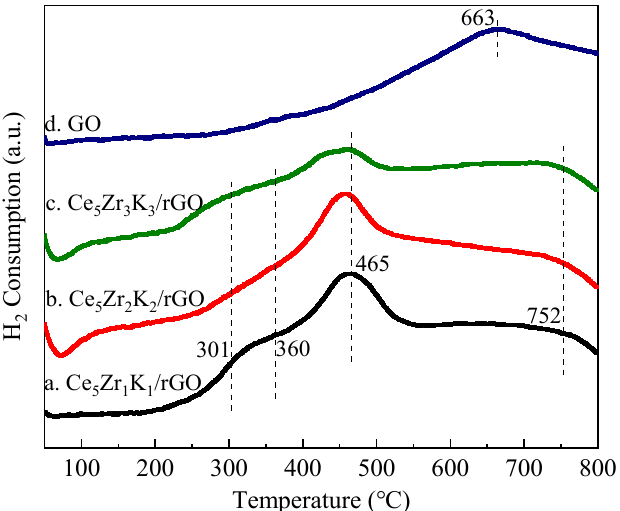
Figure 9. H 2 -temperature programmed reduction (H 2 -TPR) profiles of GO and CeZrK/rGO catalysts.